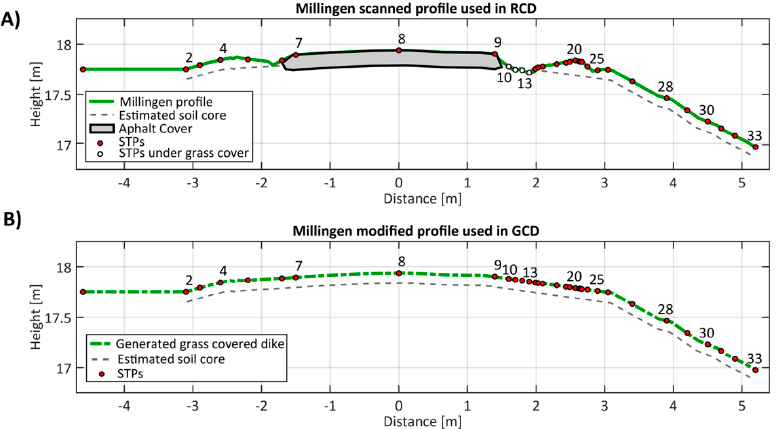
Figure 5. Cross section of ( A ) Road Covered Dike RCD; ( B ) Grass Covered Dike GCD model domains with study points (STPs) and estimated grass cover layer thickness (0.1 m).